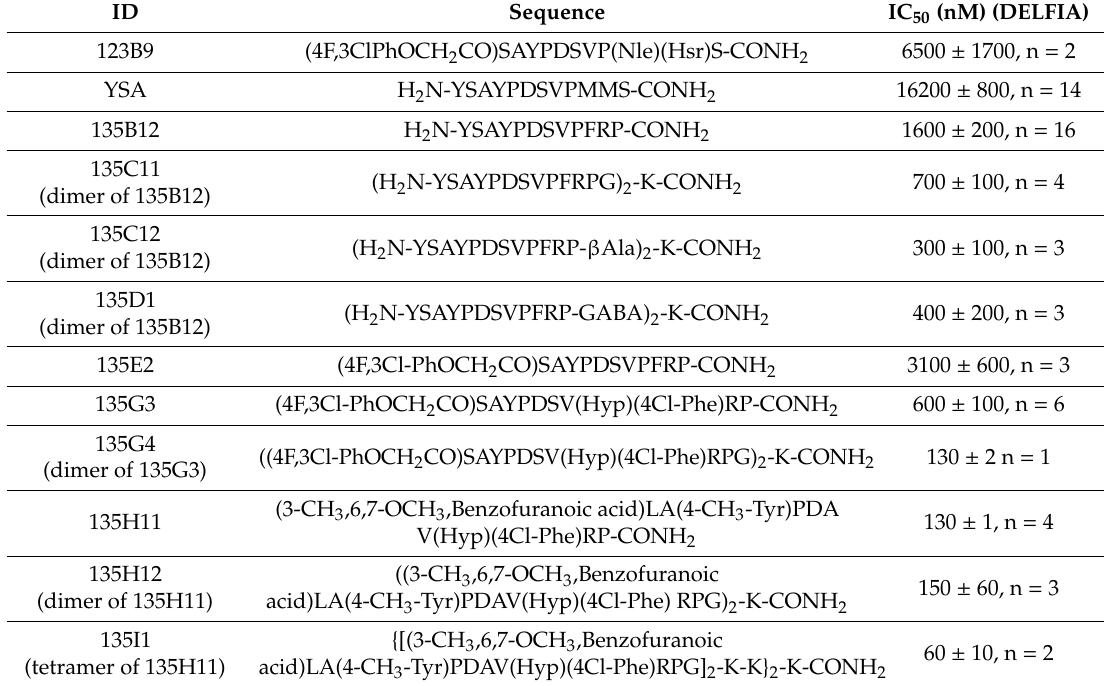
Table 1. Sequences of 12-mers and their respective dimers cited in the manuscript. IC 50 values ( µ M) were derived from the dissociation-enhanced lanthanide fluorescent immunoassay (DELFIA) assay. Reported standard errors represent number of experiments in with each having duplicate measurements. Hyp = trans 4-hydroxy- l -proline; Nle = l -norleucine; Hsr = l -homoserine; GABA = γ -aminobutyric